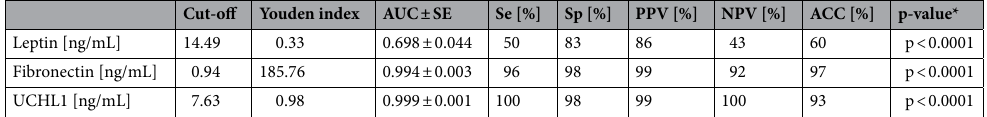
Table 5. Diagnostic usefulness of plasma leptin, fibronectin, and UCHL1 evaluation in differentiating MS patients from healthy individuals. ACC diagnostic accuracy, AUC area under the ROC curve, Cut-off (based on the highest Youden Index), MS multiple sclerosis, NPV negative predictive value, PPV positive predictive value, SE standard error, Se diagnostic sensitivity, Sp diagnostic specificity. *A p-value < 0.05 is considered to be a statistically